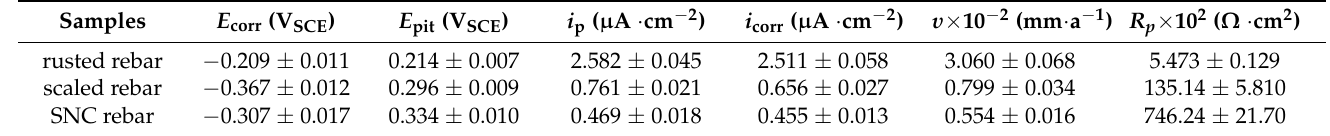
Figure 6. PDP curves of the rebar after immersion in the SCPS with chloride ions for 30 days. Table 3. Electrochemical parameters of PDP curves.